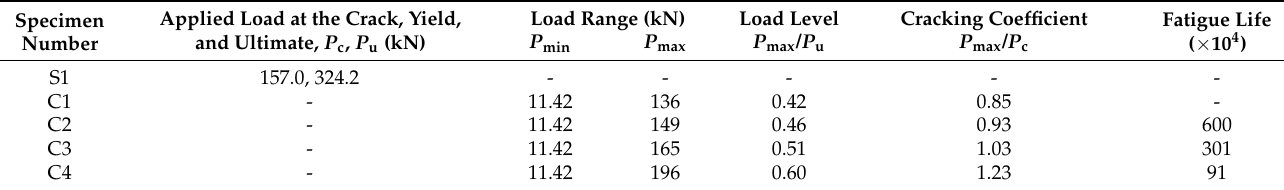
Table 3. Fatigue test conditions of model